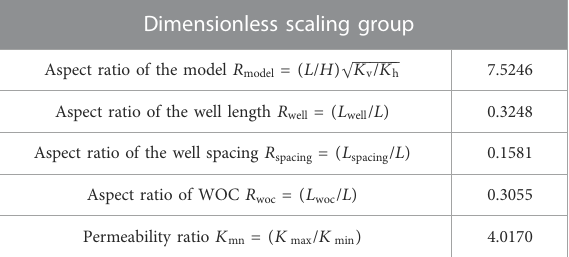
TABLE 2 Dimensionless group values calculated from the equivalent